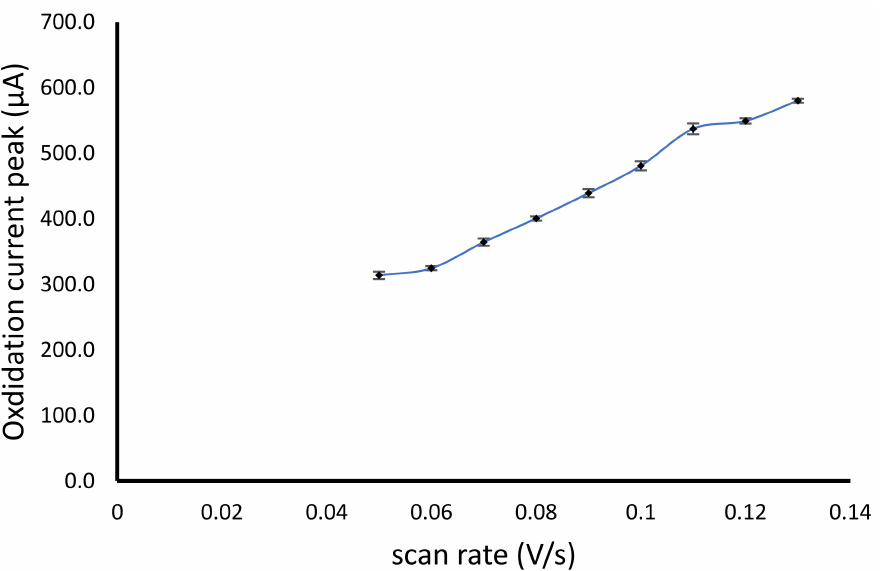
Figure 4. Scan rate optimization of the cyclic voltammetry method for hydrogen peroxide determina- tion using modified alginate NiFe 2 O 4 nanoparticles cryogel electrode.